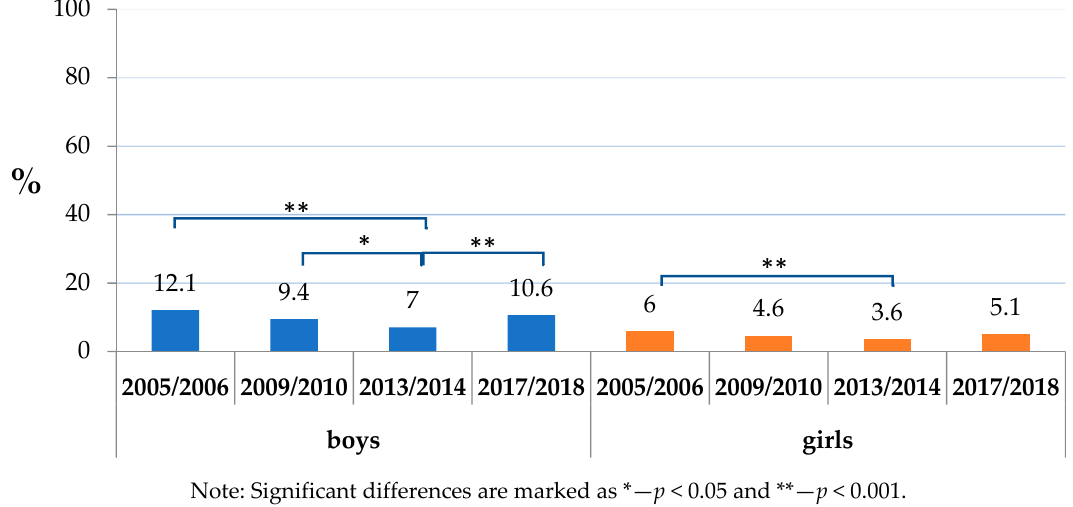
Figure 1. Toothbrushing less than once a day by sex.